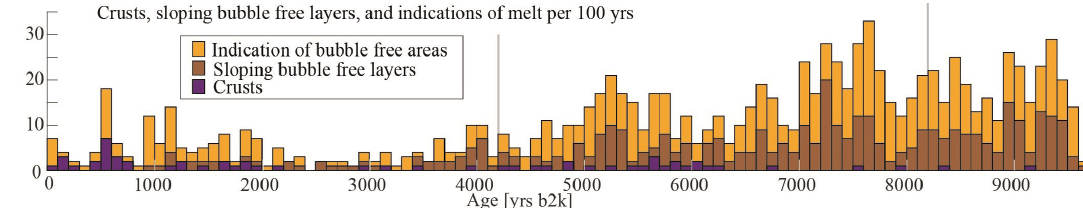
Figure A8. Number of bubble-free layers and lenses per century throughout the last 9700 years in the EastGRIP ice core. Indications of bubble-free areas, which are very uncertain melt layers and lenses that only hint at bubble-free areas, are shown in orange. Sloping bubble- free layers with a tilt of more than 10 ◦ from the horizontal, which are in general very thin and not always continuous, are shown in brown. Crusts are shown in purple. Certain/clearly identifiable crusts only occur in the last 2000 years (upper 250m). Crusts occurring beyond the last 2000 years were thought to be crusts during analysis but were later changed to uncertain melt layers. Note that the bar representing the period from 0 to 100 years b2k represents only 56 years, not 100 like the other bars, as our analysis begins in